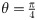
Directional antenna for node u with θ=π4.